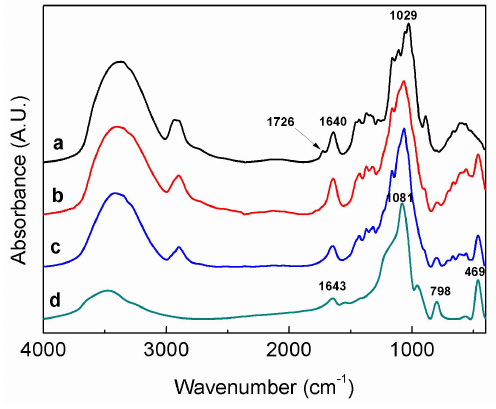
Figure 1. FTIR spectra of DAC ( a ), SiO 2 ( d ) and the SiO 2 /DAC hybrid materials with ratios of 1/10 ( b ) and 1/2 ( c ).